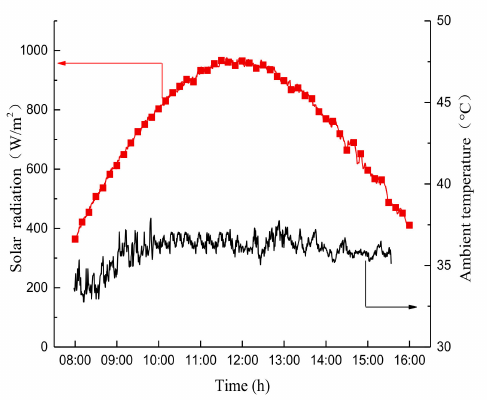
Figure 12. Solar radiation and ambient temperature on 10th July in